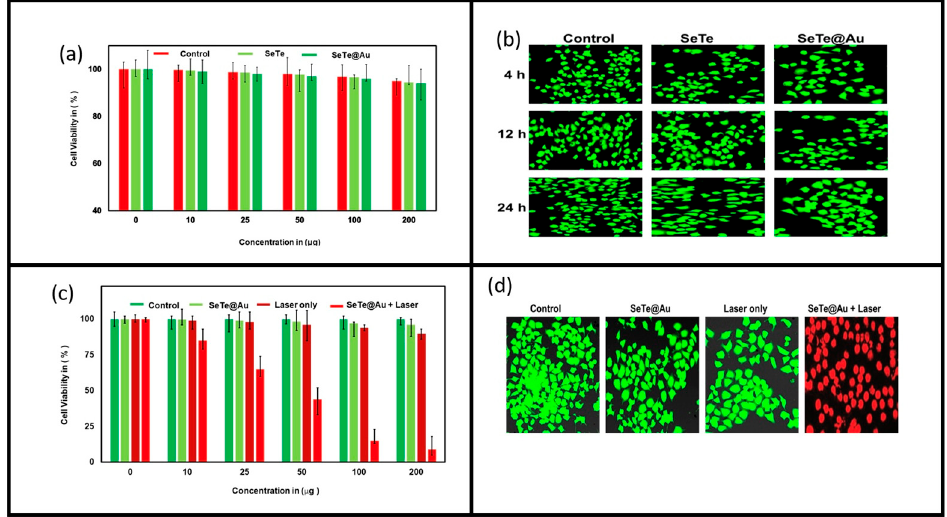
Figure 10. Cytotoxicity analyses of Se-Te and Se-Te@Au nanorods on HeLa cells using different concentrations (10, 25, 50, 100, and 200 µg/mL) ( a ), and their mapping analysis show in ( b ), at dif- ferent interval of time (4, 12, and 24 h) the control, Se-Te@Au + laser with different concentration show in ( c ), and mapping analysis after 24h are demonstrated in ( d ).